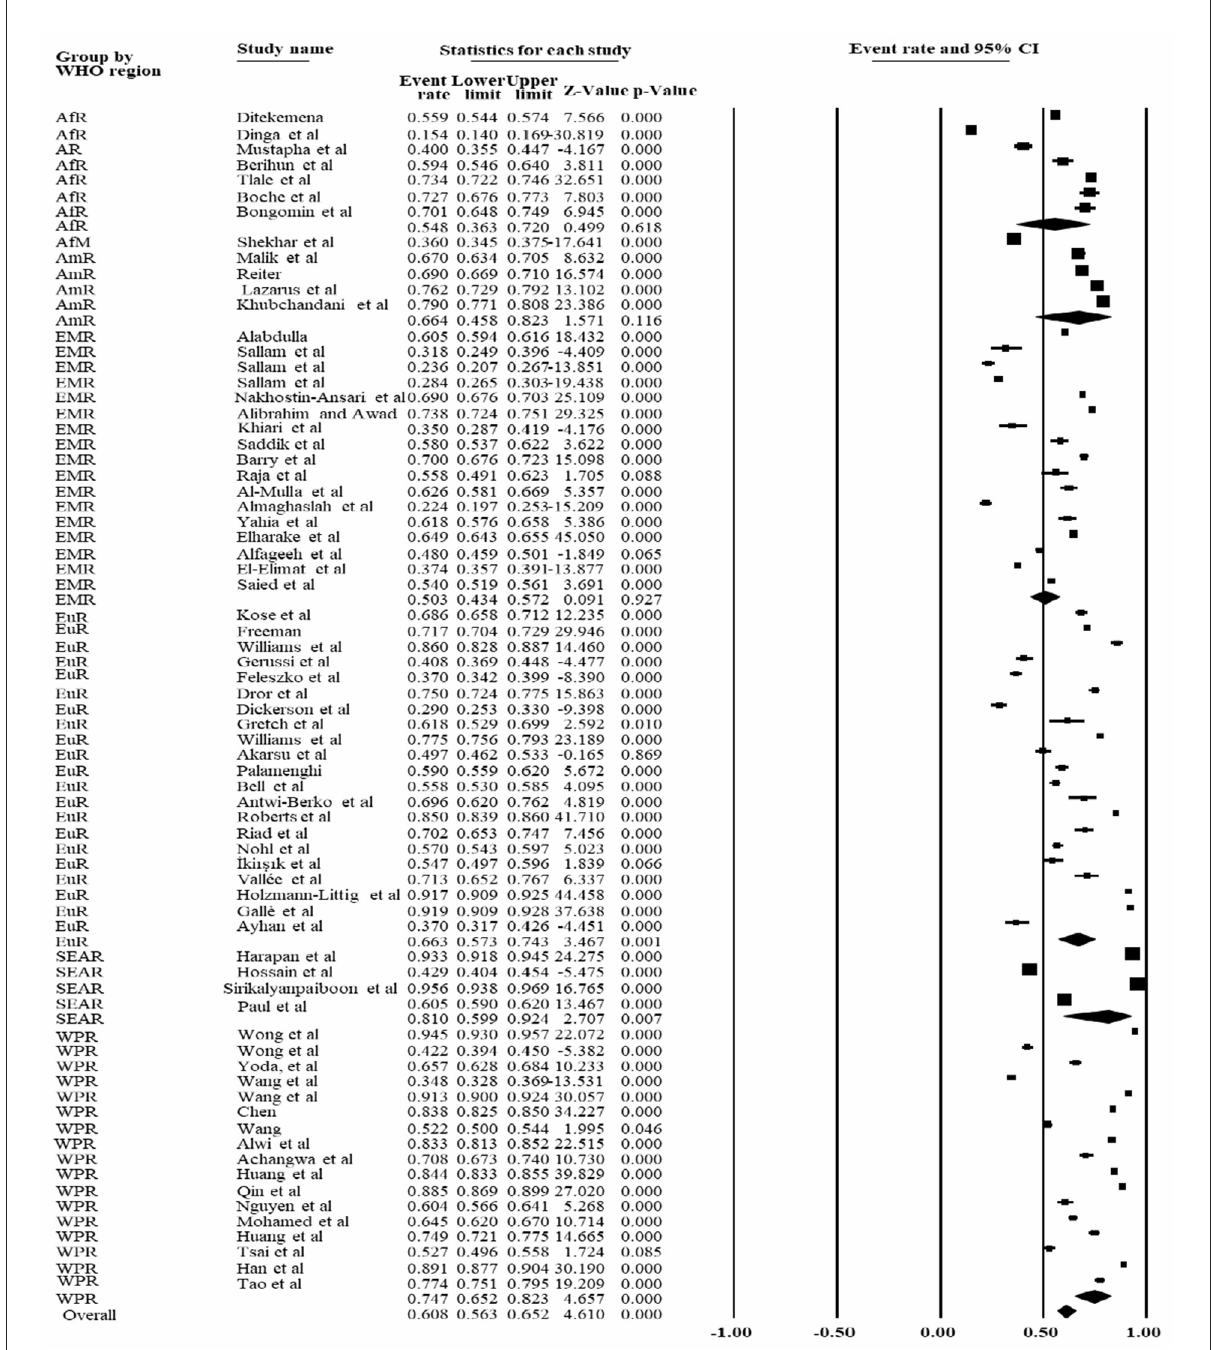
FIGURE5 Forest plot shows the subgroup analysis of the pooled COVID-19 vaccine acceptance rate based on World Health Organization classification of the region 2022. ArR, African region; AmR, American region; EMR, Eastern Mediterranean Region; SEAR, South East Asian Region; WPR, Western Pacific Region; EuR, European